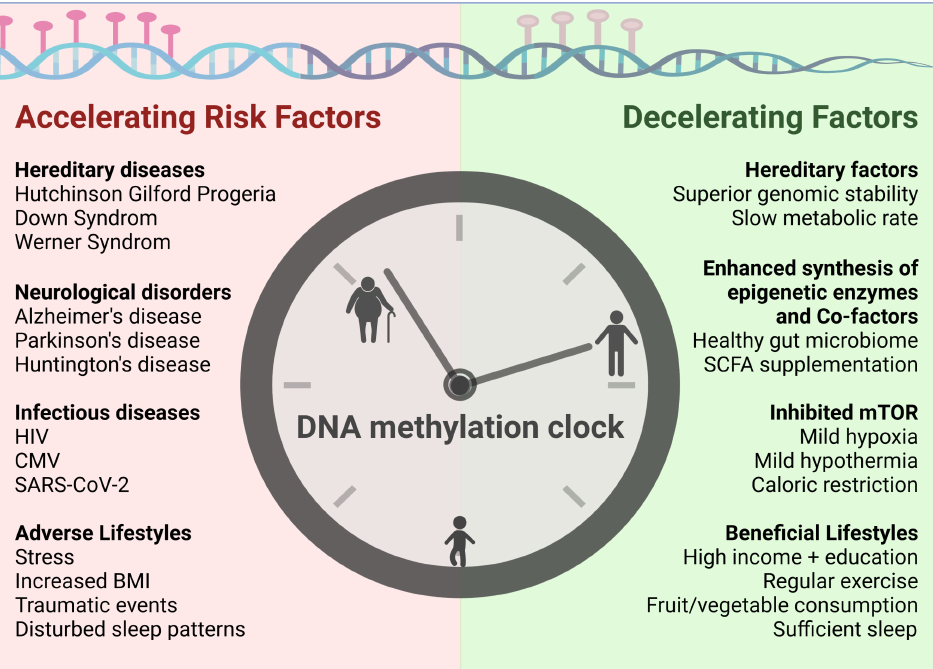
Figure 3. Factors that either negatively or positively affect epigenetic aging. Epigenetic aging as determined with DNAm clocks is accelerated in consequence of several diseases and further negatively affected by some concomitant conditions of certain lifestyles. On the other hand, there are some hereditary and environmental factors that are associated with slowed epigenetic